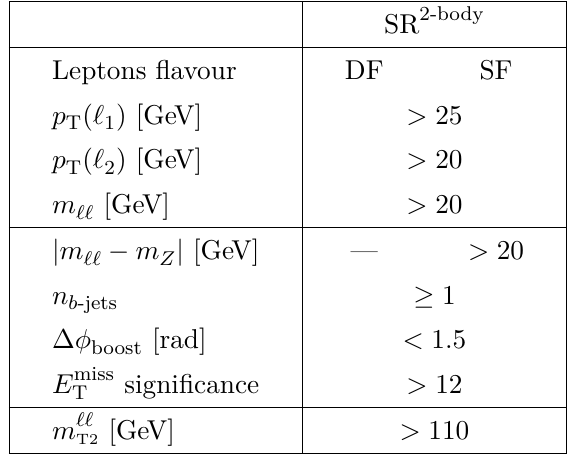
Table 2 . Two-body selection. Common definition of the binned and the inclusive sets of signal